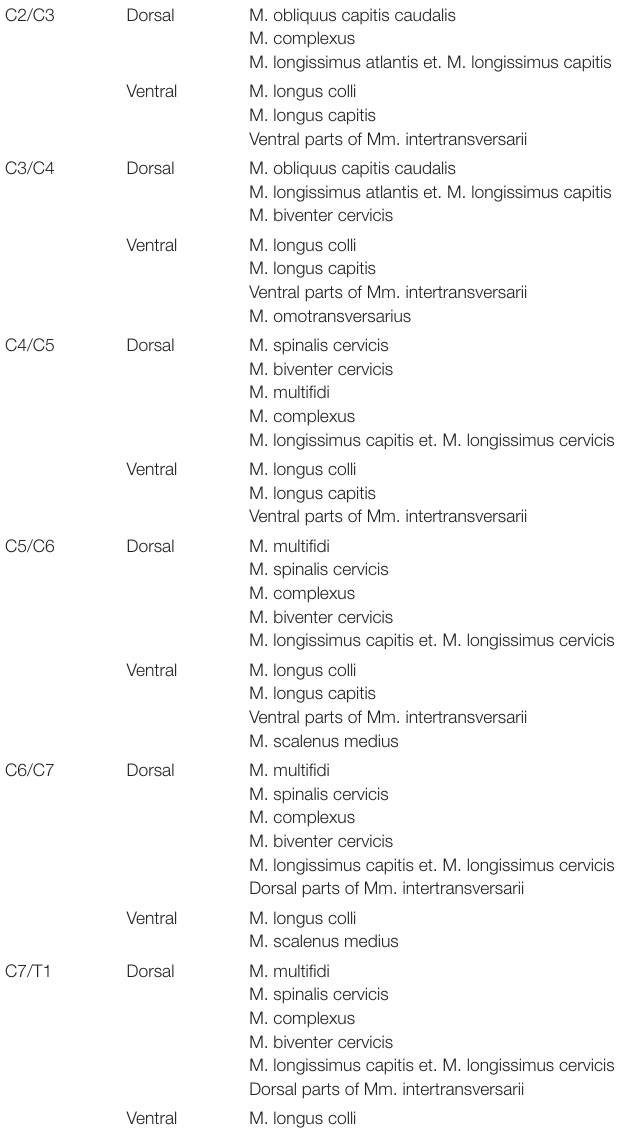
TABLE 1 | Considered dorsal and ventral paraspinal muscle groups for each cervical IVD space (10,